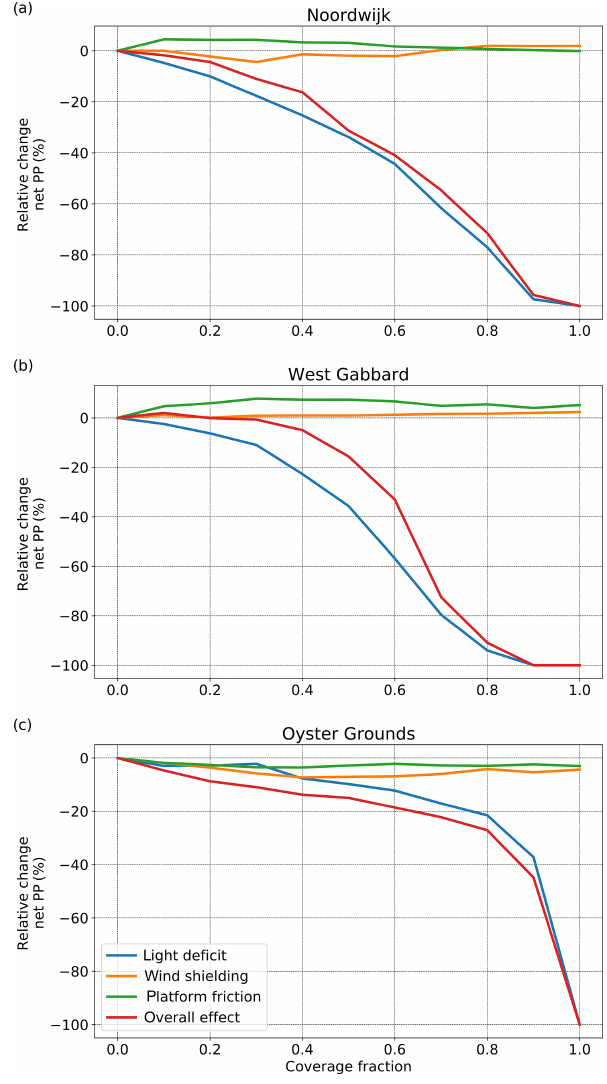
Figure 9. Relative change against the reference of net primary pro- duction with coverage for the three locations of the experiment un- der the different effects as a function of coverage with floating plat-